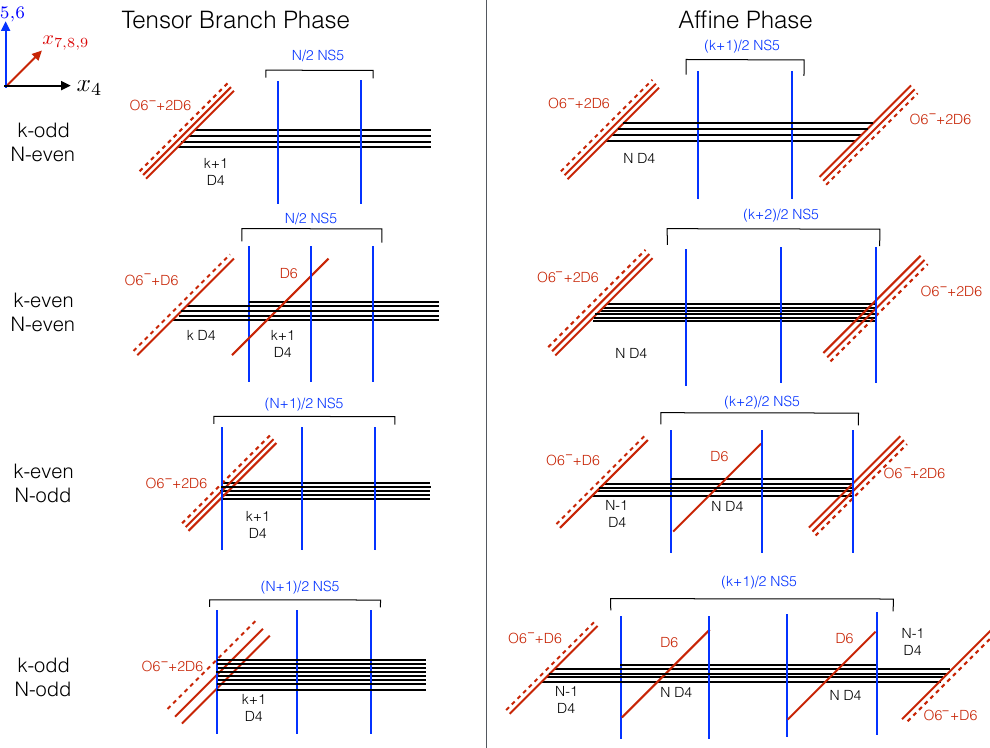
Figure 2 . Suspended brane con(cid:12)gurations for discrete quotients of the A-type class S theories on (cid:0) the tensor branch. We depict linear symmetric suspended branes con(cid:12)gurations of D4 (in black) (cid:12)lling x 0 ; : : : ; x 3 and extended along x , NS5 branes (in blue) (cid:12)lling x 0 ; : : : ; x 3 , wrapping x 4 ; x 5 6 (i.e. the two torus directions), and probing x 6 , O6 (cid:0) + 2D6 (in red) (cid:12)lling x 0 ; : : : ; x 3 and extended along x . The other con(cid:12)gurations are given by moving the O6 (cid:0) + 2D6 on top of an NS5 7 ; x 8 ; x 9 brane, or by moving one NS5 brane inside the O6 (cid:0) + 2D6 system depending on whether k and N are even or odd. In this (cid:12)gure, only the physical branes have been illustrated. However in the presence of orientifold O 6 (cid:0) there is an equivalent mirror image of the brane system, which in the a(cid:14)ne cases makes the quiver circular, and the x direction 6